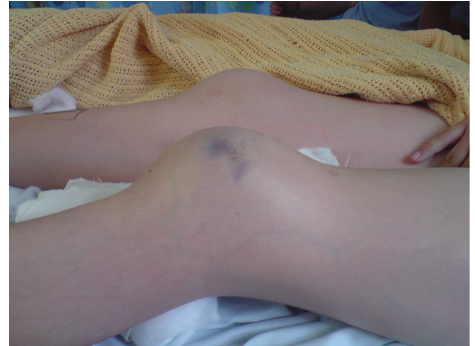
Figure 1: Clinical appearance of the knees on initial presentation.